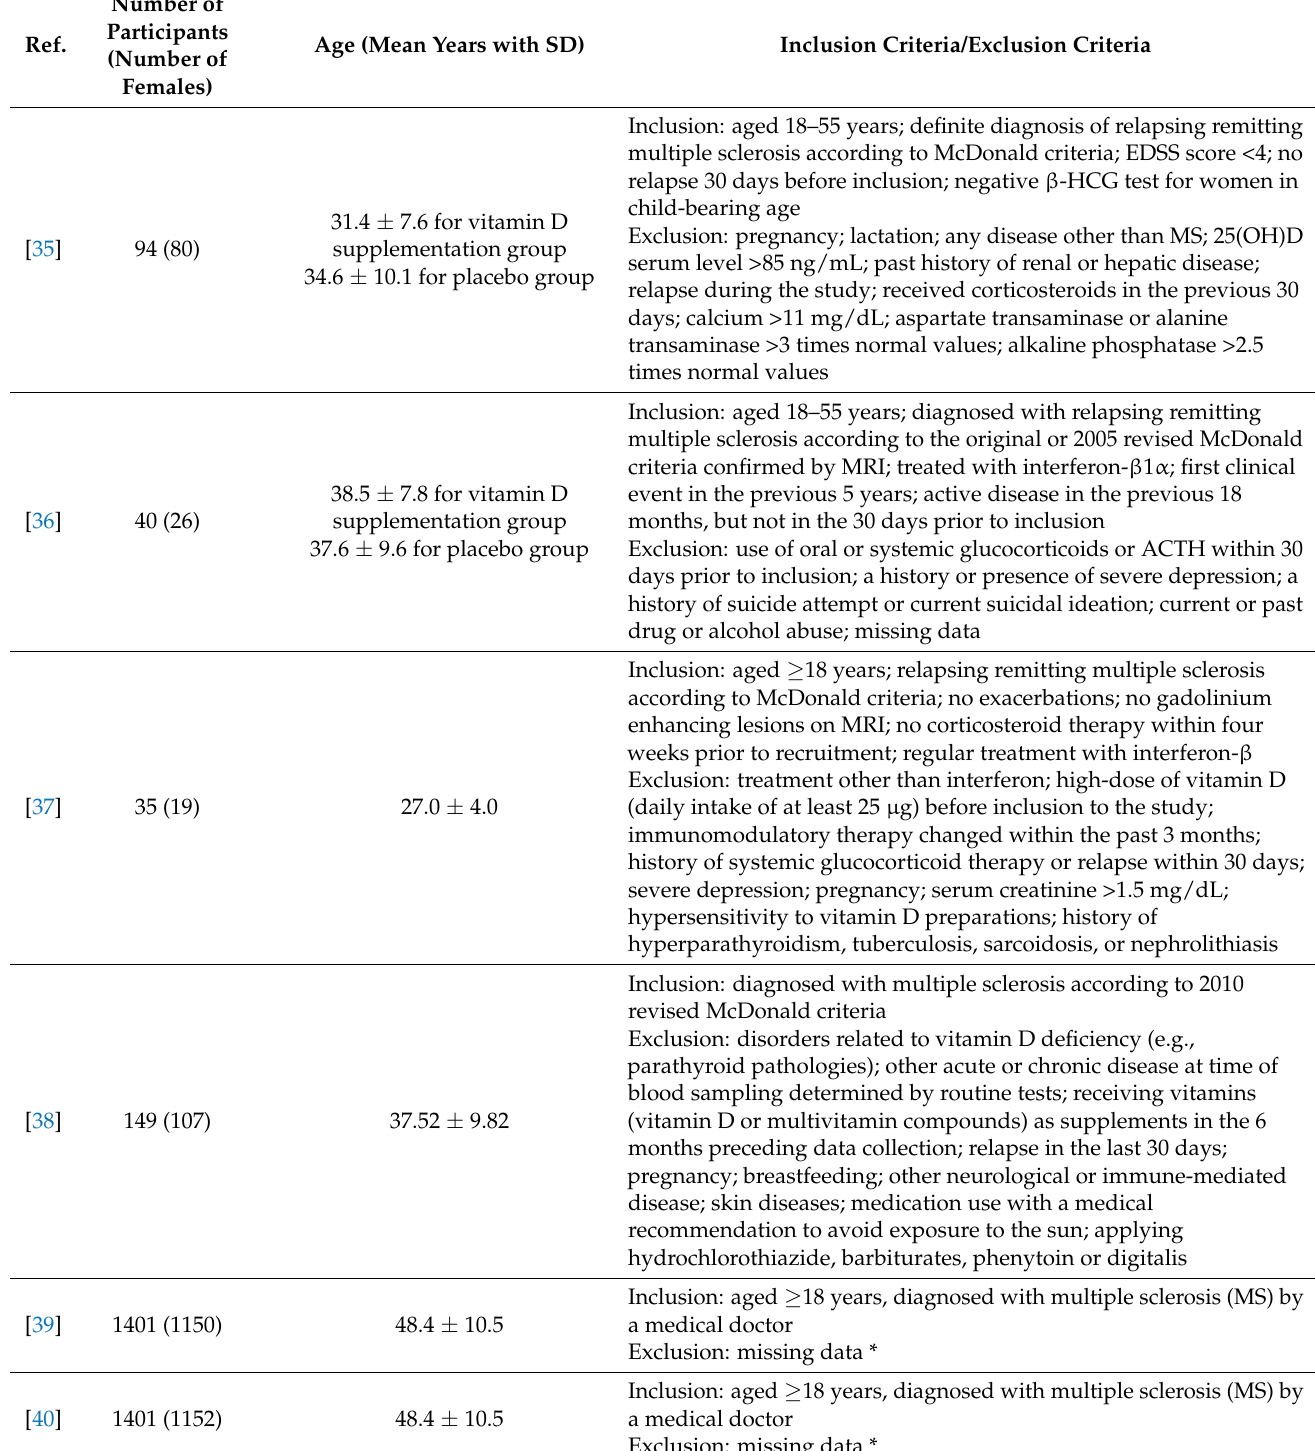
Table 3. The characteristics of the multiple sclerosis (MS) patients assessed within the studies included in the systematic